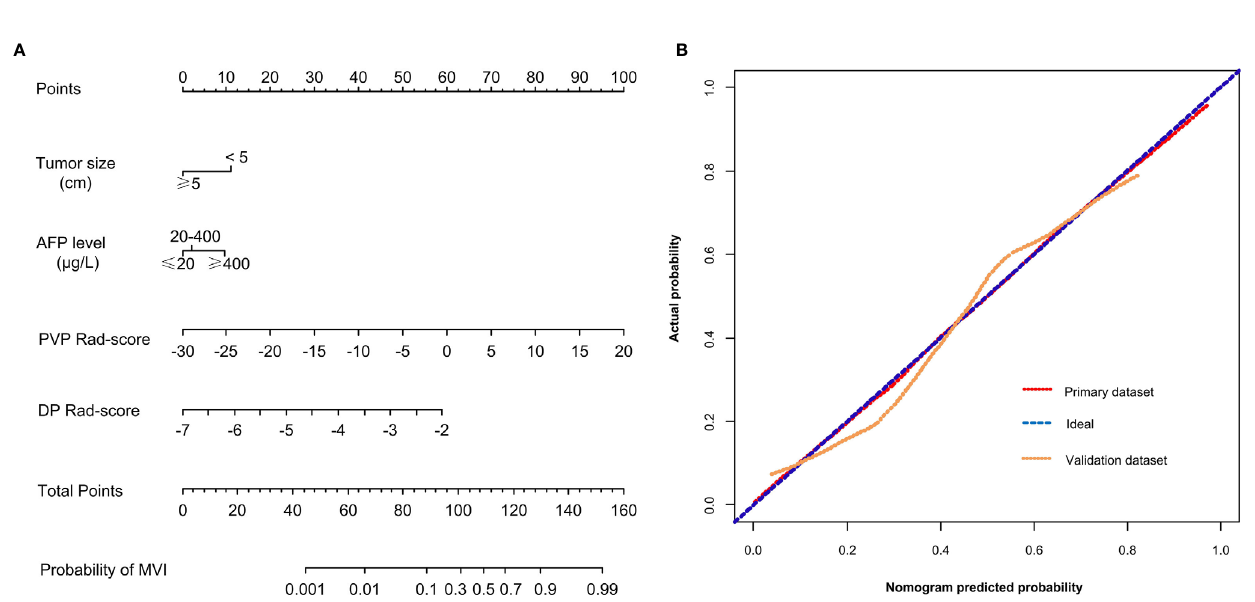
FIGURE 2 | (A) A radiomics nomogram combining the AFP level, tumor size, PVP Rad-score, and DP Rad-score. (B) Calibration curves of the radiomics nomogram in the primary and validation datasets. AFP, a -fetoprotein; PVP, portal venous phase; DP, delay phase; Rad-score, radiomics